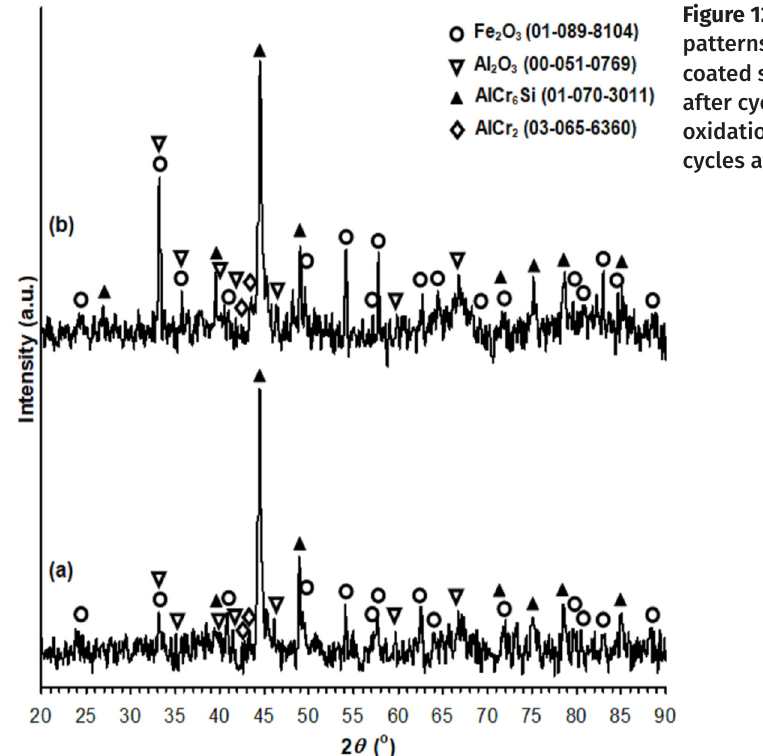
Figure 12. XRD patterns of coated substrate after cyclic oxidation for 8 cycles at 800